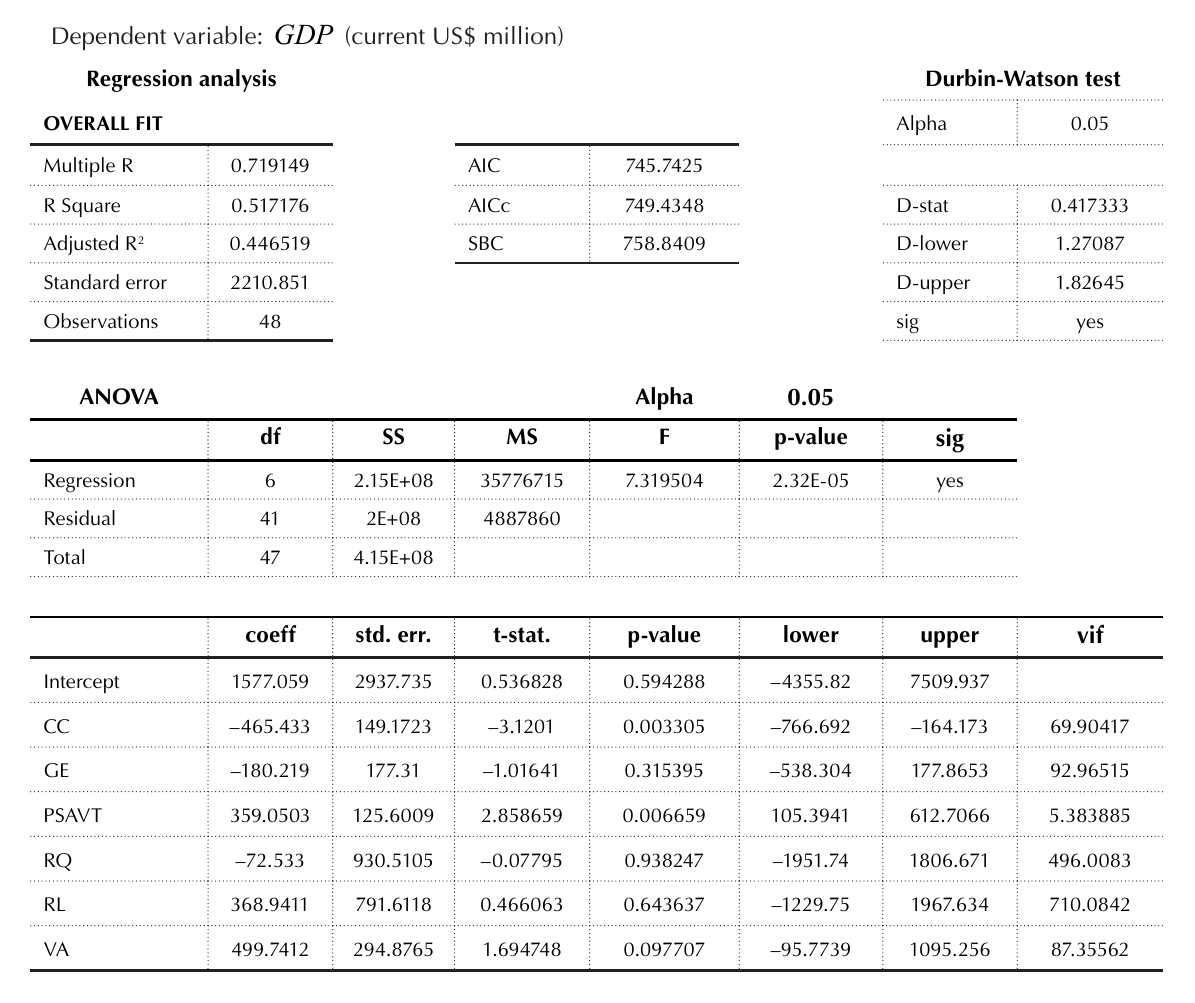
Table 5. Regression analysis, influence of sound corporate governance on economic growth in